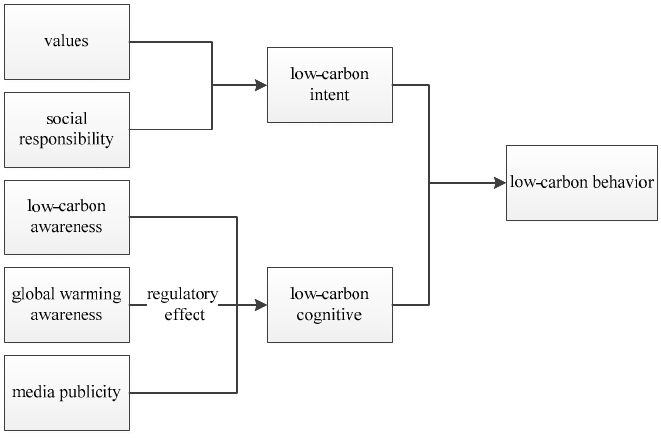
Figure 1. Logic diagram 1.